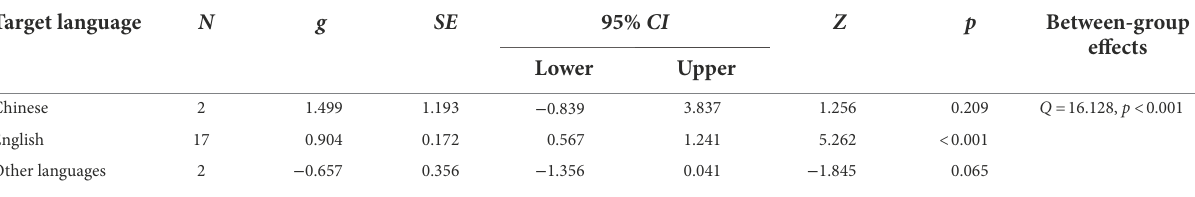
TABLE 3 Impact of XR on the learning effects, by target language.